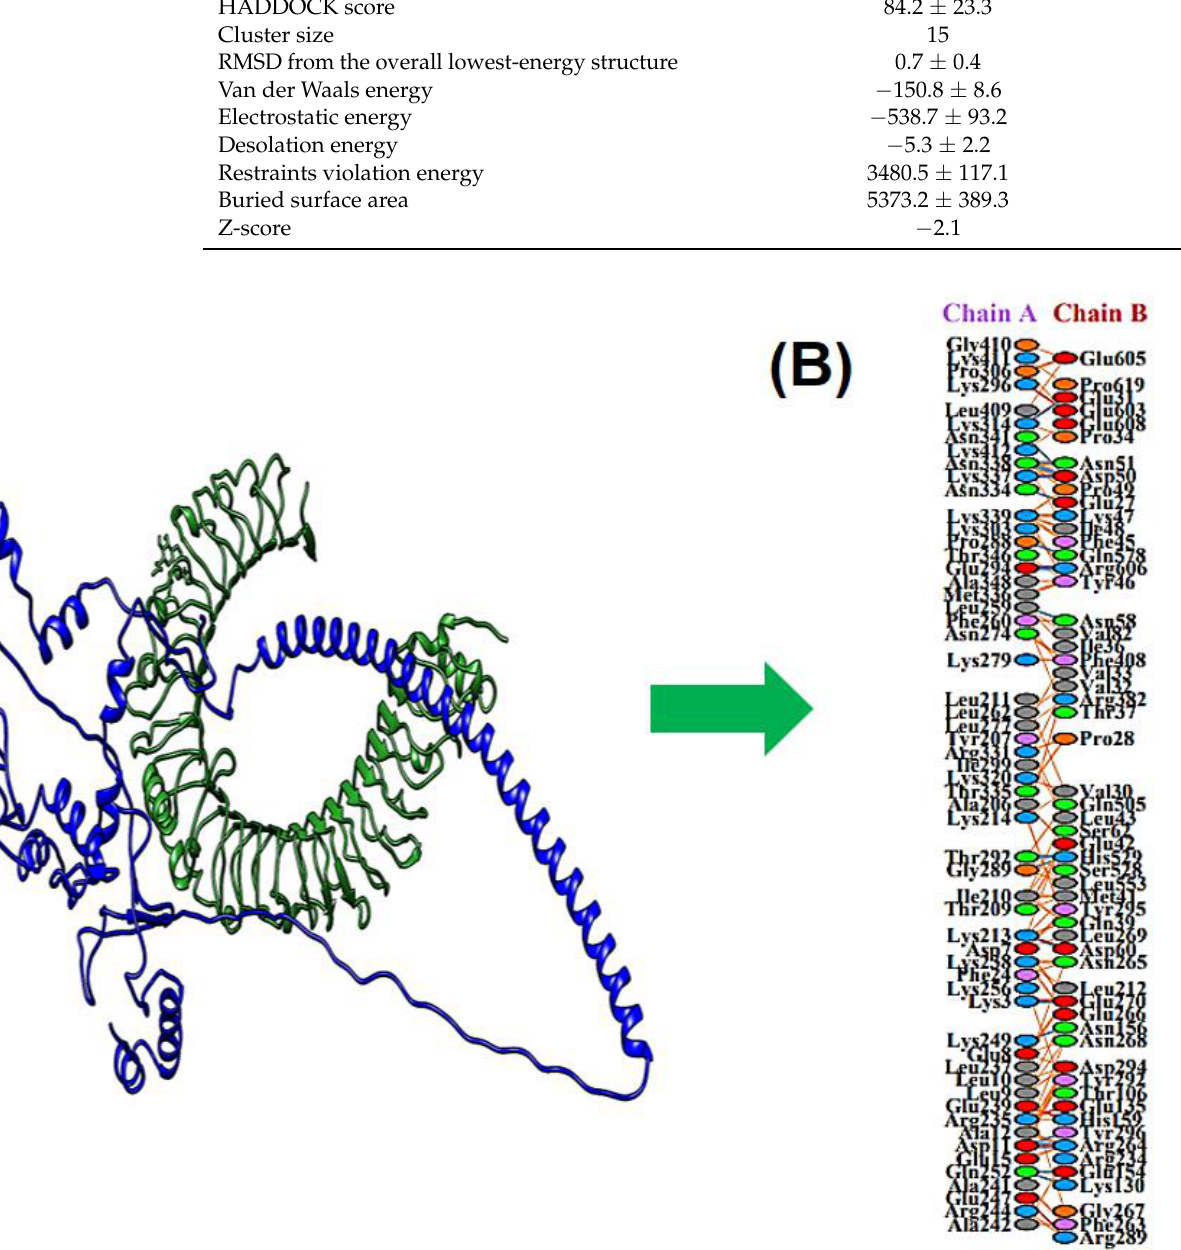
Figure 5. The TLR-4 is represented in green (Chain A) and the MEV is represented in blue color (Chain B). The section ( A ) in figure represent the vaccine and TLR-4 docking complex and the section ( B ) in figure represent interactions.